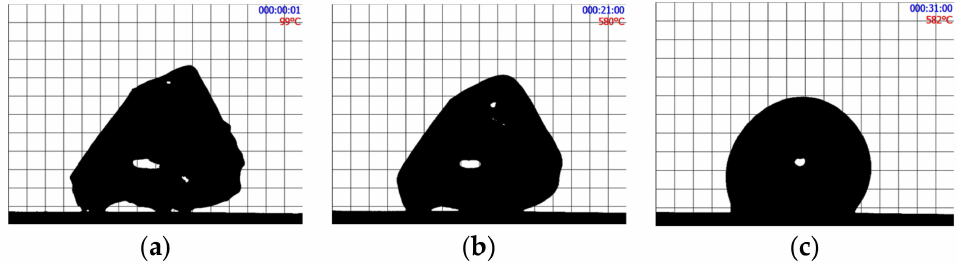
Figure 4. SiTiFD irregular glass sample heated at 853 K. ( a ) Before reaching the thermal plateau. ( b ) At the beginning of the thermal plateau at 853 K. ( c ) After 10 min. The fast change in shape is recorded as roundness on time, as shown in Figure 5. During heat treatment, pictures were taken every 15